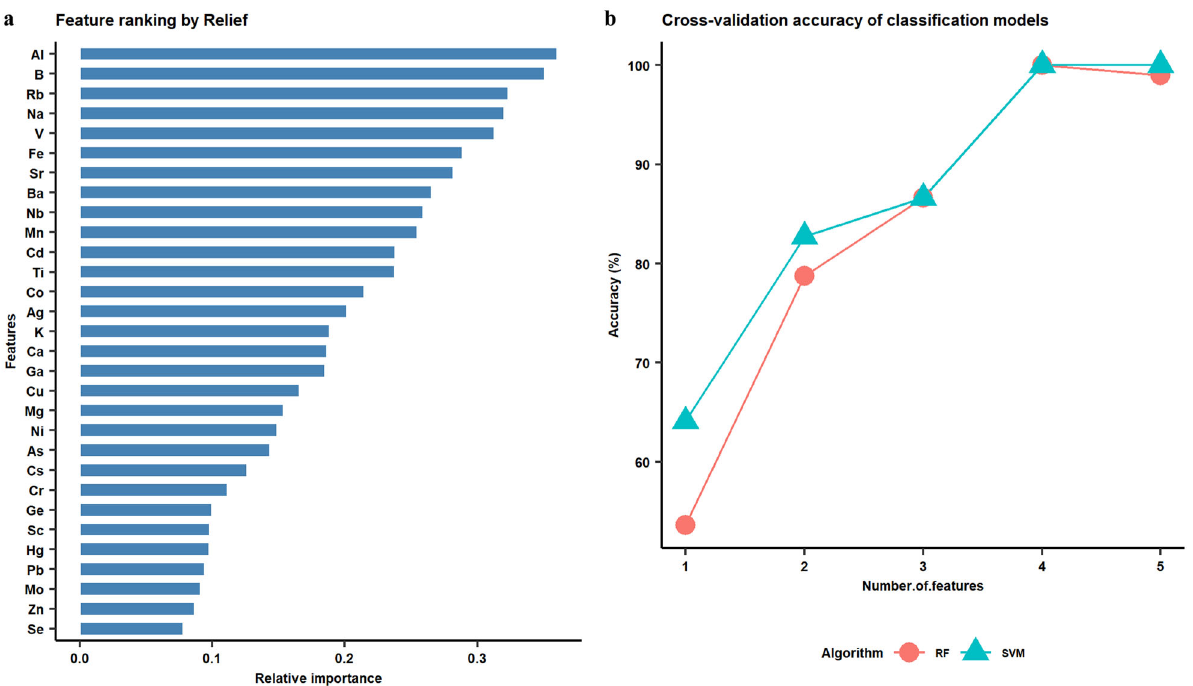
Fig. 2 Feature ranking by Relief algorithm and model optimization with cross-validation. a Relative importance of each feature based on Relief. b Cross-validation accuracy of classi fi cation models built with different numbers of features.